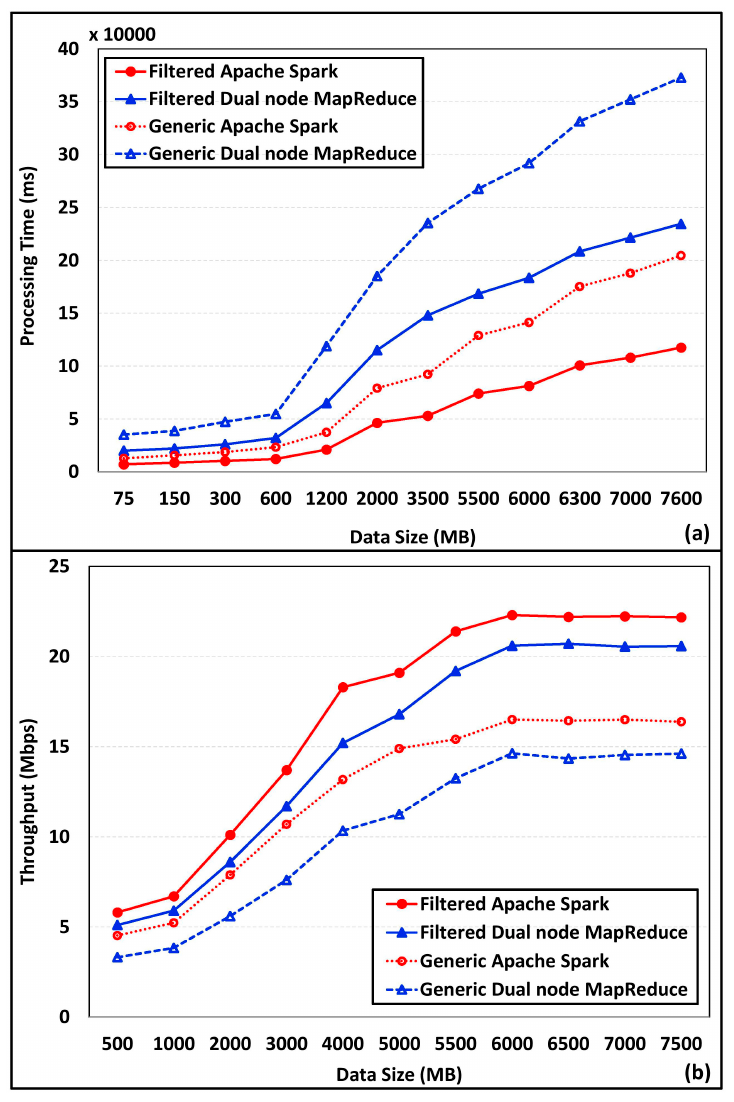
Figure 10. Filtration incorporated processing performance. ( a ) Processing time, ( b ) Throughput.